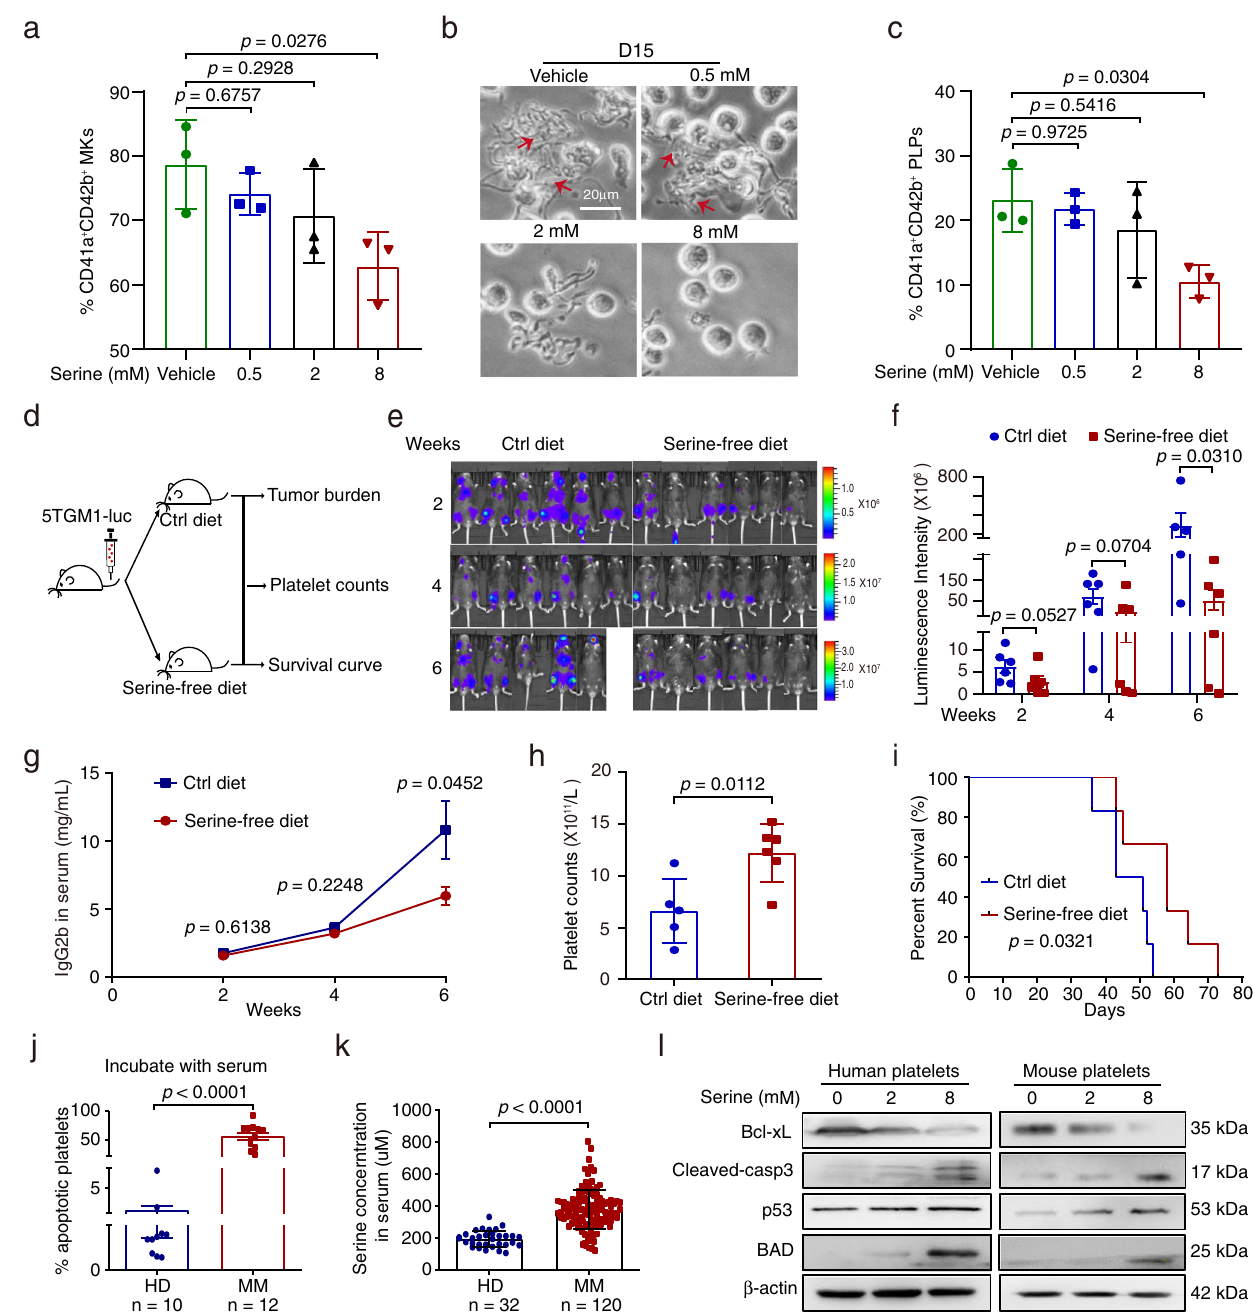
Fig.3|Serineinhibitsmegakaryopoiesisandthrombopoiesisbothinvitroand invivo.a TheproductionofCD41a + CD42b + MKsofCD34 + cellstreatedwithindicated concentration of serine (mean±SD, n =3 independent experiments). b , c Phase- contrast images of proplatelet formation and the production of CD41a + CD42b + PLPs atday15fromCD34 + cellstreatedwithindicatedconcentrationsofserine(mean±SD, n =3 independent experiments). The scale bar is 20 µ m. d Schematic diagram of the